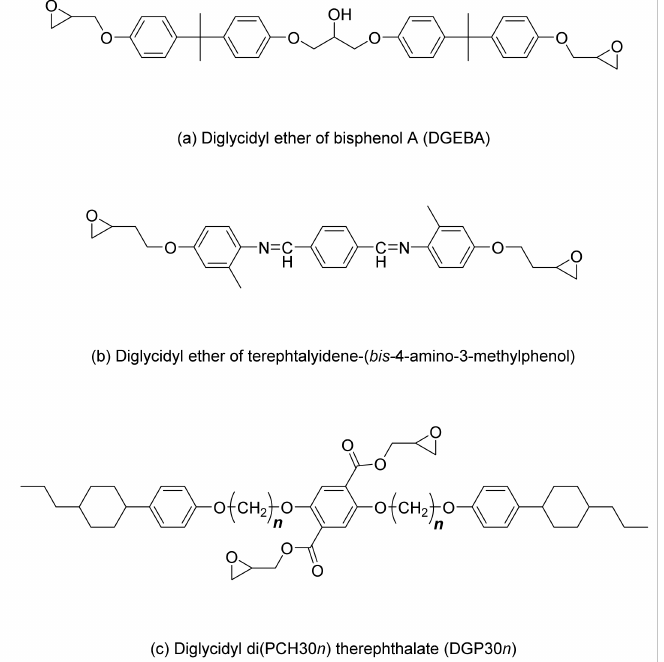
Figure 8. Molecular structure of ( a ) diglycidyl ether of bisphenol A (DGEBA), ( b ) diglycidyl ether of terephthalyidene (DGETAM), and ( c ) diglycidyl diphenylcyclohexyl (PCH30 n ) phthalate (DGP30 n ). Reproduced from Ref. [31] with permission from The Royal Society of